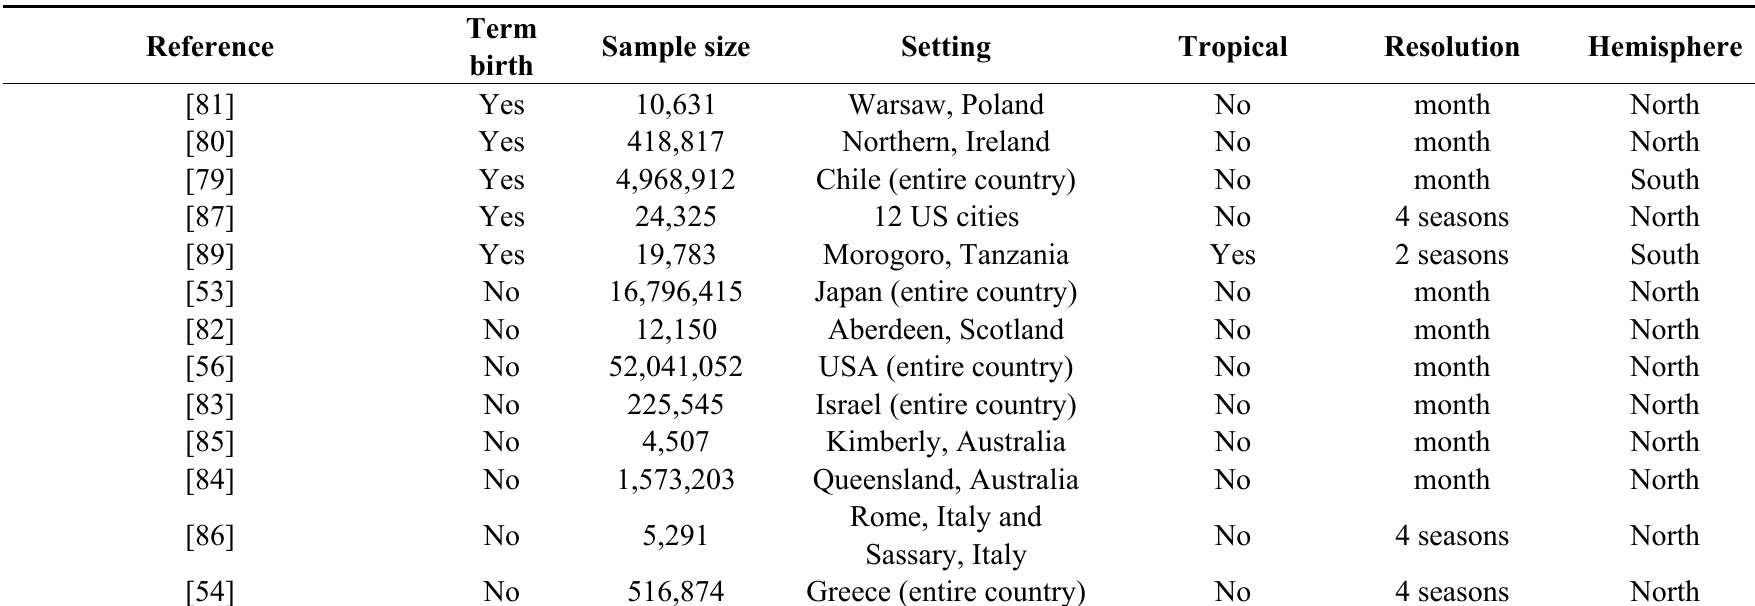
Table A20. Studies examined for the meta analysis of the influence of month of birth on birth